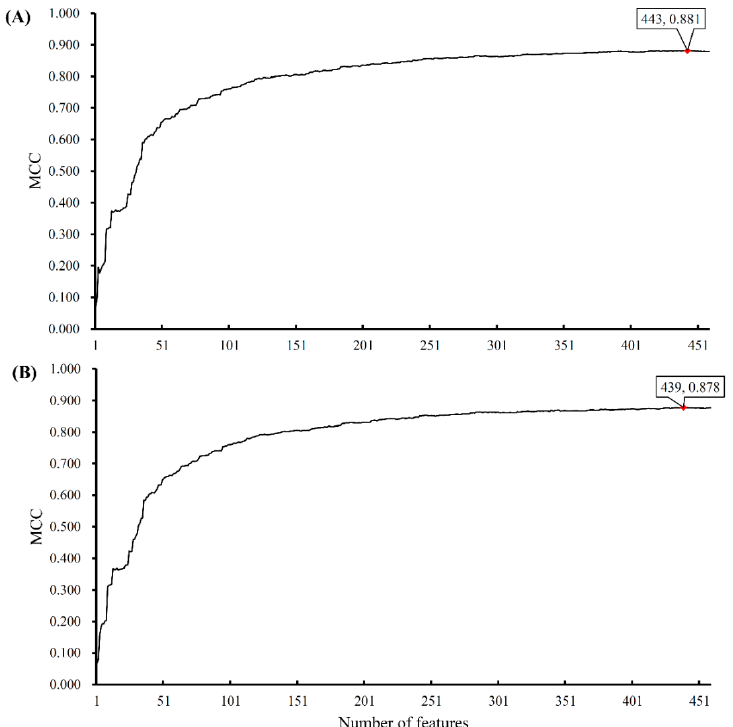
Figure 2. IFS curves derived from the IFS method and SVM classifiers. The x-axis is the number of features involved in building classifiers, while the y-axis is their corresponding Matthew’s correlation coe ffi cient (MCC) values. ( A ) The IFS curve yielded by 10-fold cross-validation. ( B ) The IFS curve yielded by 5-fold cross-validation.